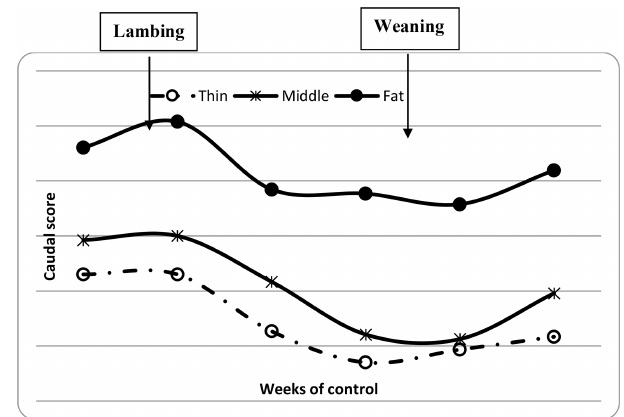
Figure 3. Variation of ewe caudal scores from lambing to weaning